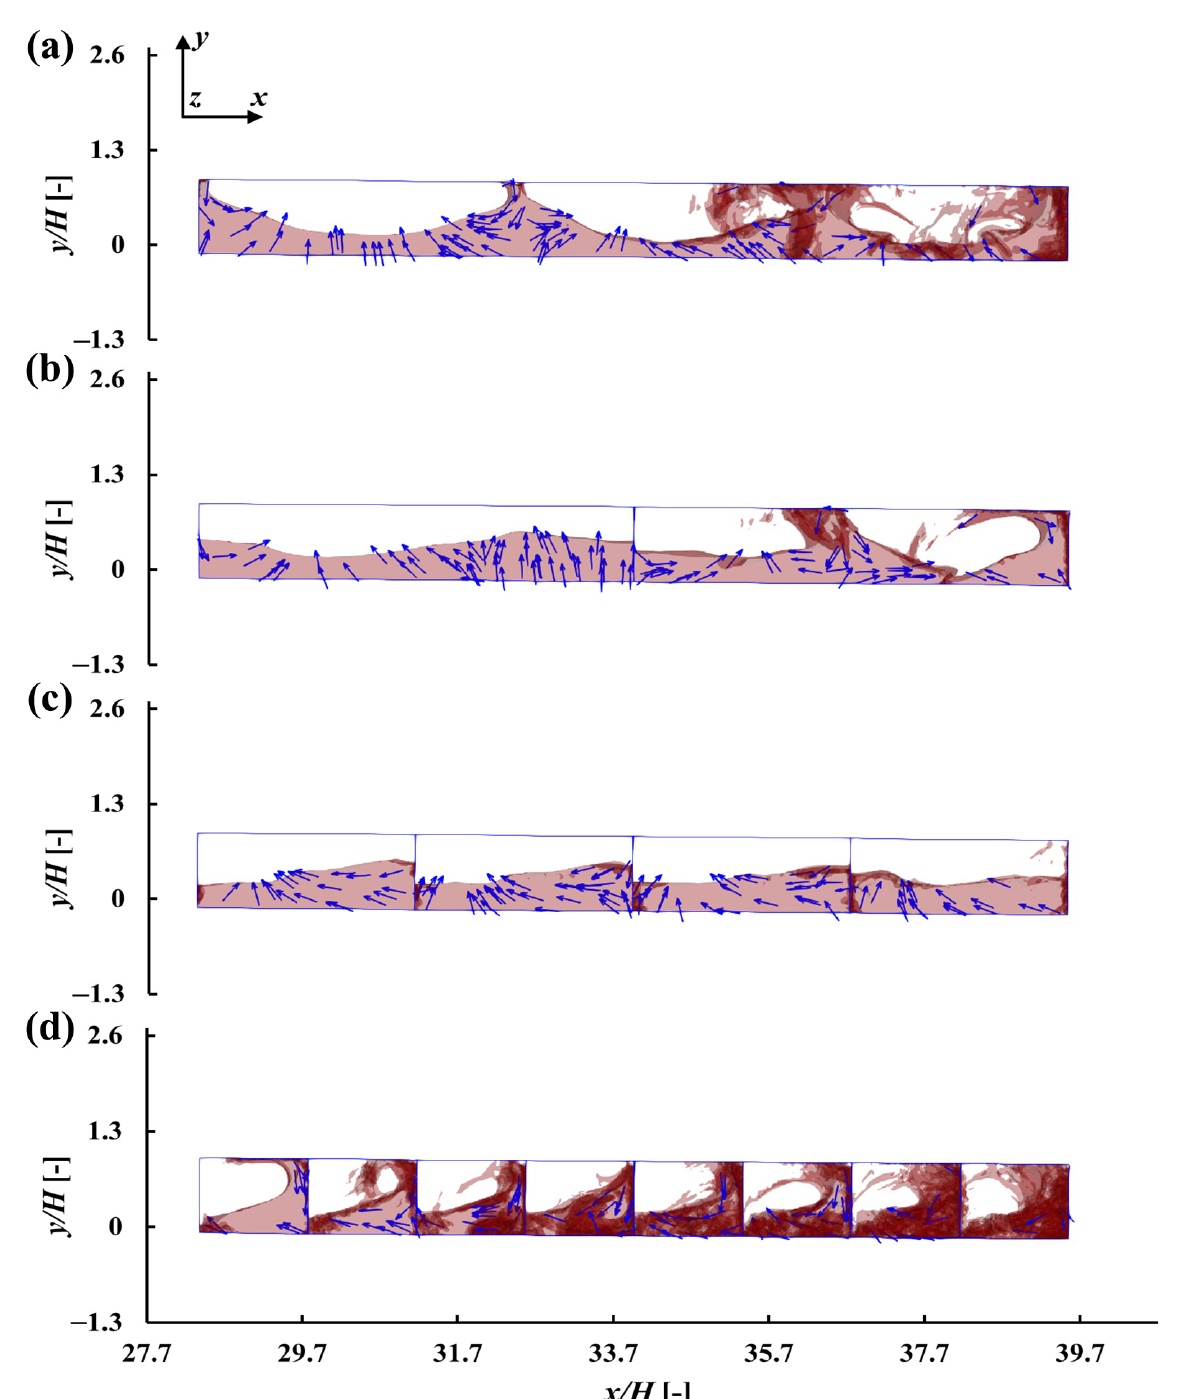
Figure 16. Snapshots for the sloshing tank with D i = 0.25 at t / T = 6.0 for ( a ) N c = 1, ( b ) N c = 2, ( c ) N c = 4 and ( d ) N c = 8. Water phase is shown as transparent red with dark red representing the free surface. Blue arrows show the general direction of motion of the sloshing